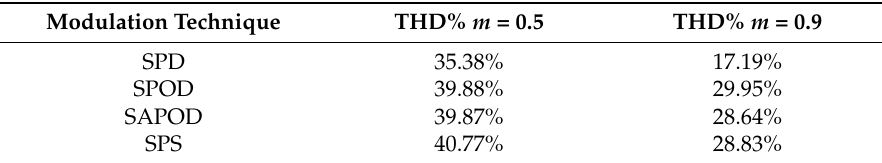
Table 2. THD% for modulation indexes equal to 0.5 and 0.9.